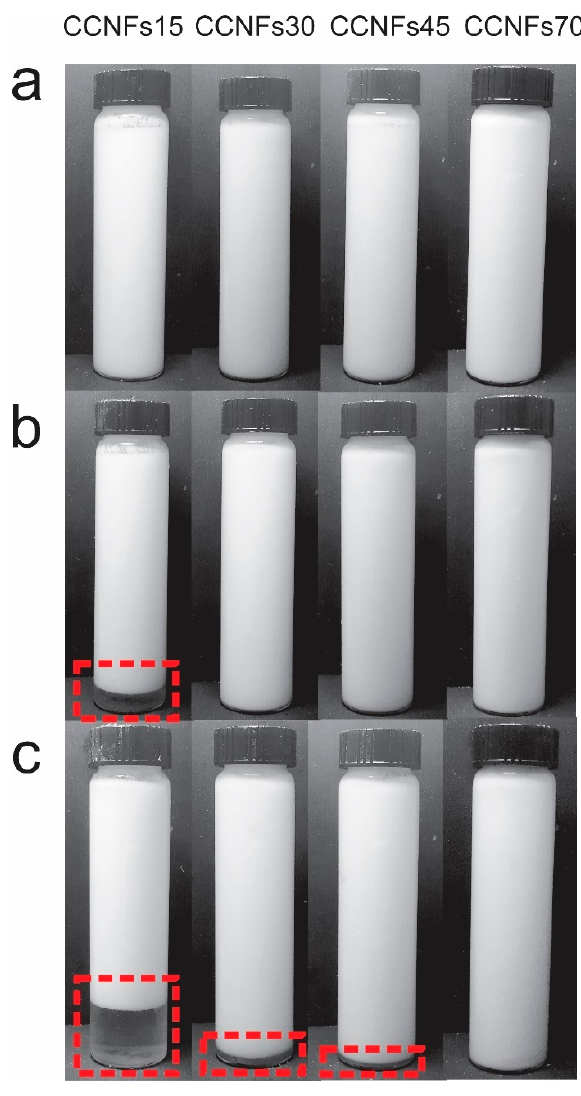
Figure 2. Emulsions manufactured with coconut oil, after 0 h ( a ), 1 h ( b ) and 5 days ( c ) of static storage. Dashed-line rectangle encloses the creaming of the suspension.